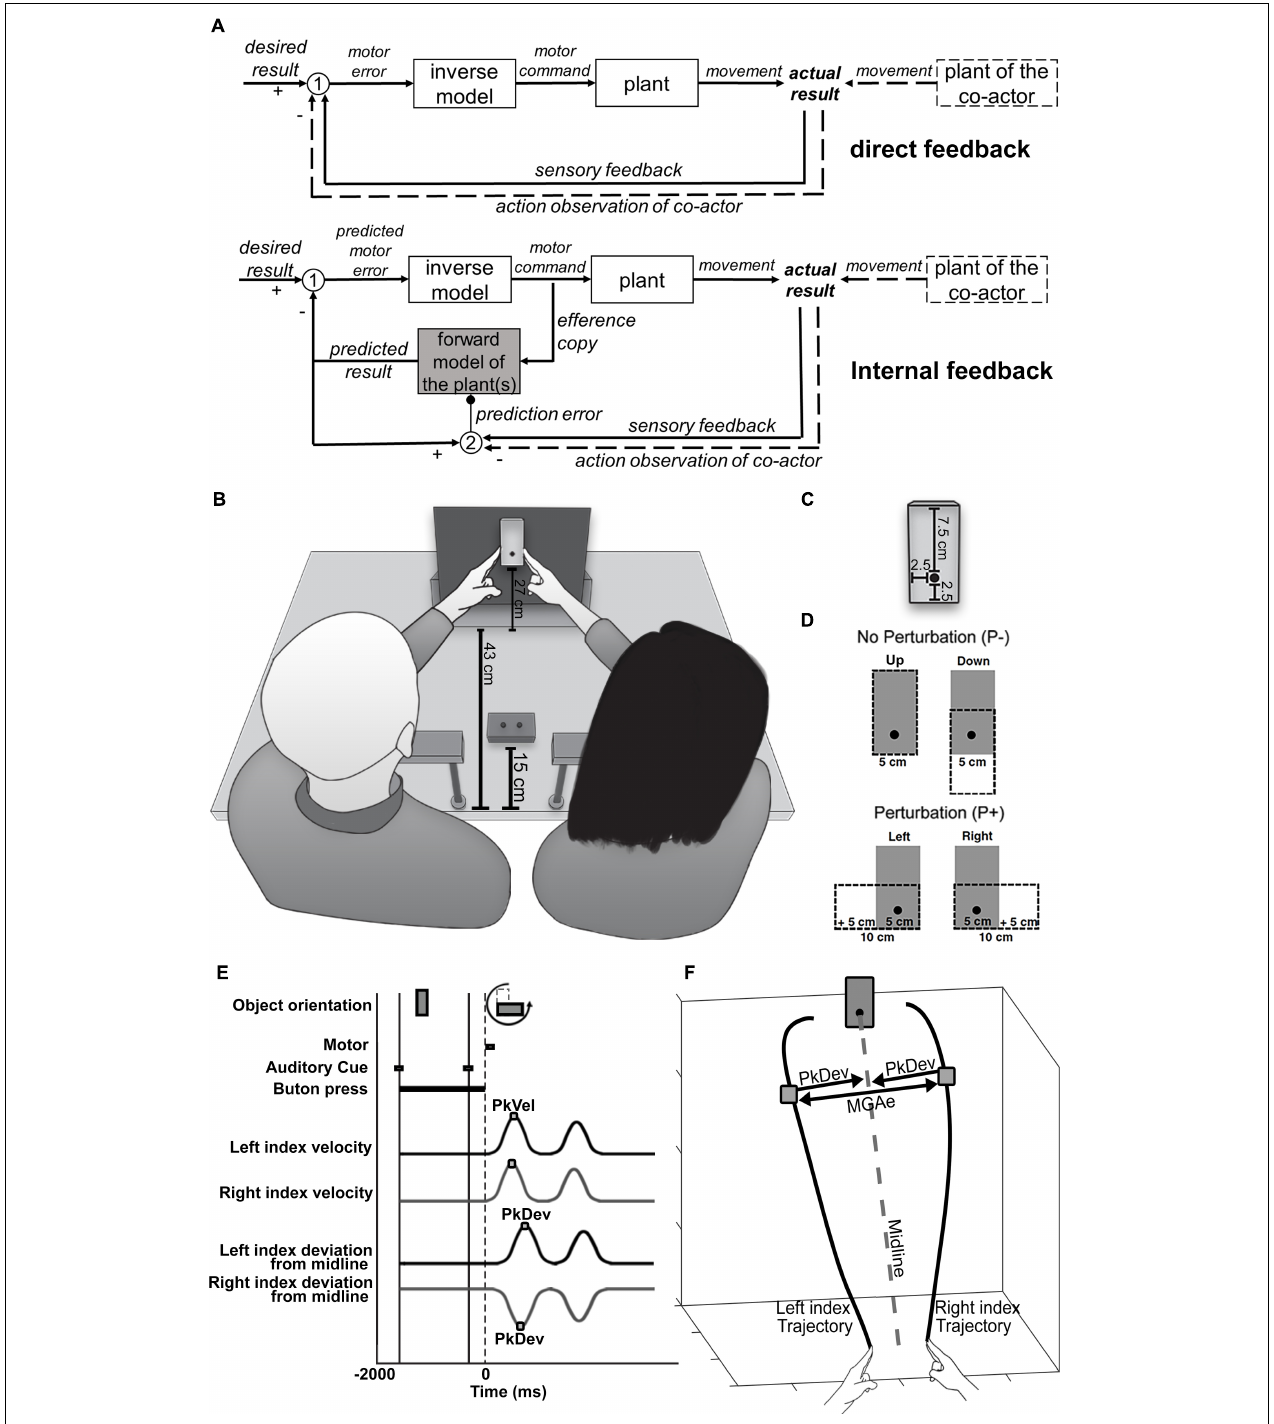
FIGURE 1 | (A) Flow charts of sensorimotor control systems. Top chart : direct feedback. Sensory feedback conveying information about the current state of the body/the actual result is compared with a desired result (white circle 1). The resultant difference (“motor error”) is converted by a motor control component, called an “inverse model,” into a motor command to be sent to a plant. The plant could be a single muscle or a larger part of the body. It generates a movement that alters the actual result until the difference between sensory feedback and desired result is reduced to an error of zero. Bottom chart : internal feedback. Here the (predicted) motor error is computed from internal information rather than sensory information, which is gathered from a copy of the motor command. This “efference copy” is sent to a virtual representation of the plant (“forward model”) to calculate a virtual sensory signal that predicts the effect of the physical plant on the actual result